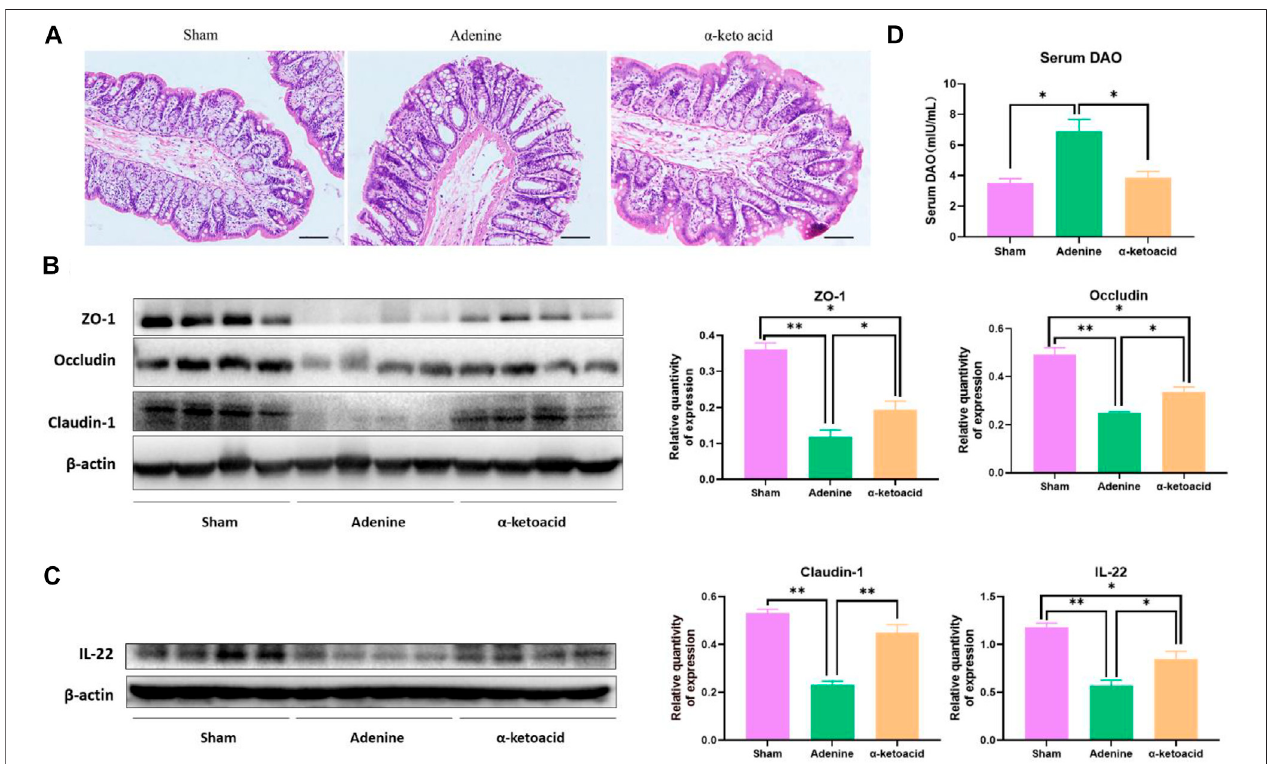
FIGURE2| α -Ketoacidimprovedtheintestinalbarrierintegrityinadenine-inducedCKDrats. (A) Hematoxylinandeosinstainingofcolontissue. (B) Theexpression of tight junction protein of the intestinal mucosal barrier (occludin, claudin-1, and ZO-1) in colon tissue. (C) The expression of IL-22 in colon tissue. (D) Serum level of diamine oxidase. Data are presented as the means ± standard error of the mean, n (cid:1) 8 rats per group (* p < 0.05, ** p < 0.001).